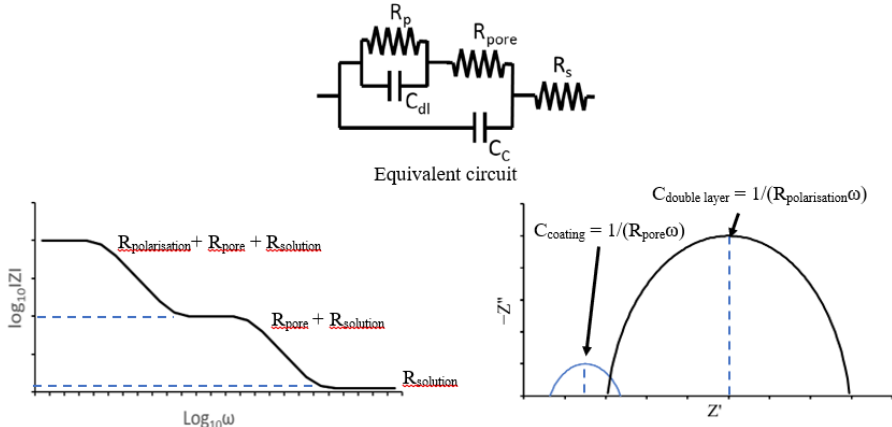
Figure 24. Example Bode (left) and Nyquist (right) plots for a coated metal electrode under EIS testing modelled on the equivalent circuit for a coated metal electrode (top).